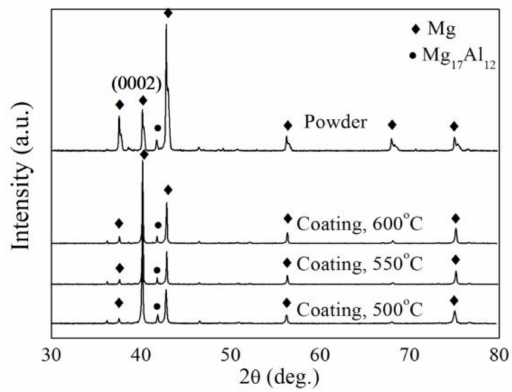
Figure 5. XRD patterns of AZ91D powder and AZ91D coatings deposited at different temperatures.